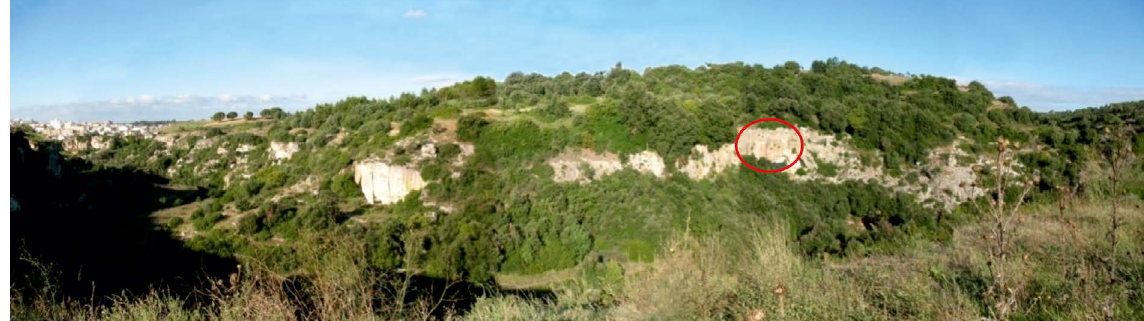
Figure 1. Panoramic view of the ravine of Ginosa, in the red circle the Oscurusciuto rock shelter (Photo A.